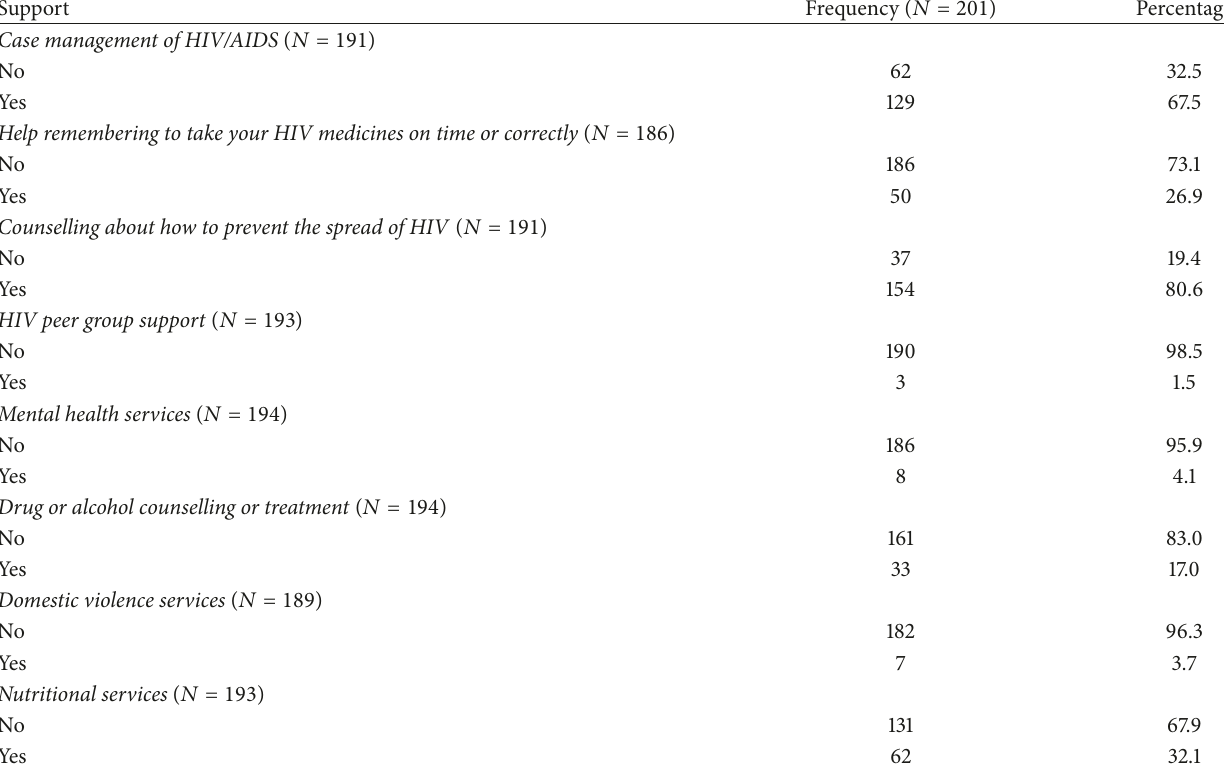
Table 3: Characteristics of support services participants received 12 months prior to the commencement of the study.